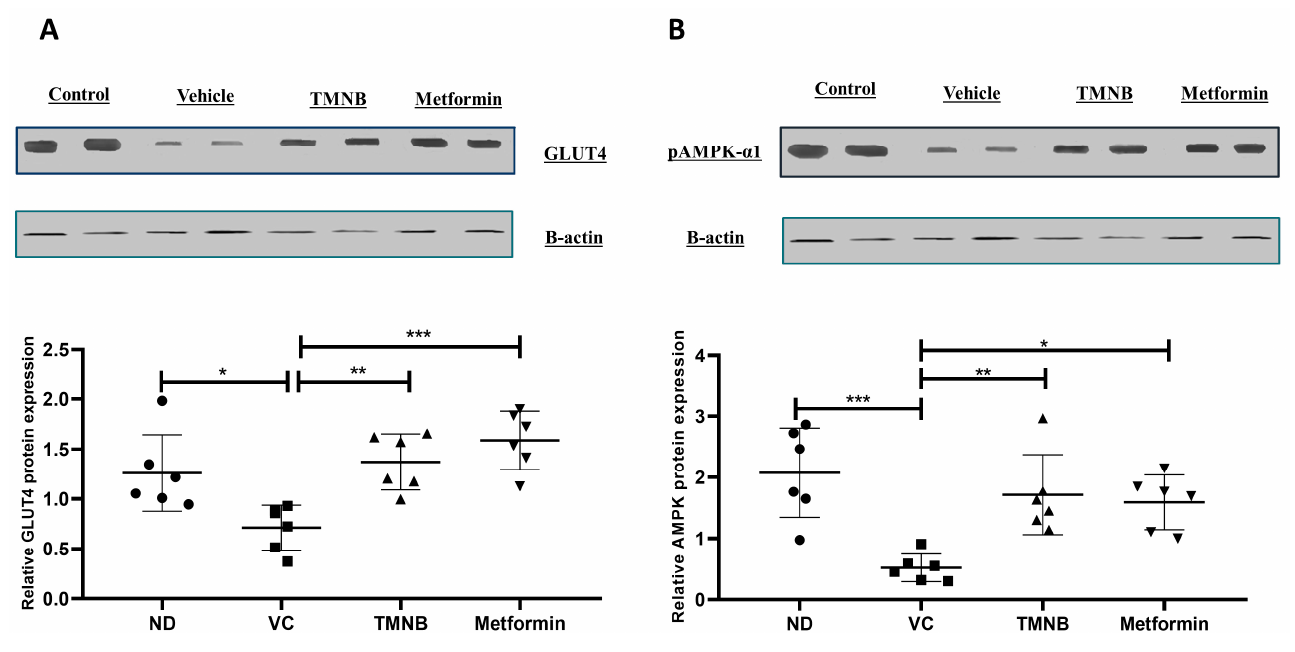
Figure 4. 2 (cid:48) ,3,3,5 (cid:48) -Tetramethyl-4 (cid:48) -nitro-2 (cid:48) H-1,3 (cid:48) -bipyrazole upregulated GLUT4 and AMPK expres- sion in adipose tissue. TMNB significantly upregulated adipose tissue GLUT4 ( A ) and AMPK ( B ) expression in diabetic rats. Rats were fed HFD for 3 weeks, followed by a single dose of STZ injection (40 mg/kg); after diabetes was confirmed, rats were treated with 10 mg/kg TMNB or 200 mg/kg metformin for 10 days. At the end of the experiment following euthanasia, adipose tissue was isolated and homogenized before western blotting was performed. One-way ANOVA was followed by Tukey post-hoc multiple comparison test, * < 0.05, ** < 0.01, *** < 0.001. ND; non-diabetic, VC; vehicle control, TMNB; 2 (cid:48) ,3,3,5 (cid:48) -Tetramethyl-4 (cid:48) -nitro-2 (cid:48) H-1,3 (cid:48) -bipyrazole. To further elucidate the mechanism by which TMNB improves insulin sensitivity and reduces glucose levels, hepatic glucose transporter 2 (GLUT2) and AMPK protein expres- sion were measured. GLUT2 protein expression was significantly downregulated in the presence of T2D (Figure 5A, n = 6, p < 0.001); whereas, TMNB significantly upregulated GLUT2 expression compared to the vehicle control diabetic group (Figure 5A, n = 6, p < 0.01). Metformin was also able to upregulate GLUT2 expression compared to vehicle con- trols (Figure 5A, n = 6, p < 0.01). Similarly, AMPK expression was significantly downreg- ulated as a result of T2D (Figure 5B, n = 6, p < 0.001), and treating diabetic rats with either controls (Figure 5B, n = 6, p < 0.001). No difference was observed in GLUT2 and AMPK expression between TMNB and metformin groups.